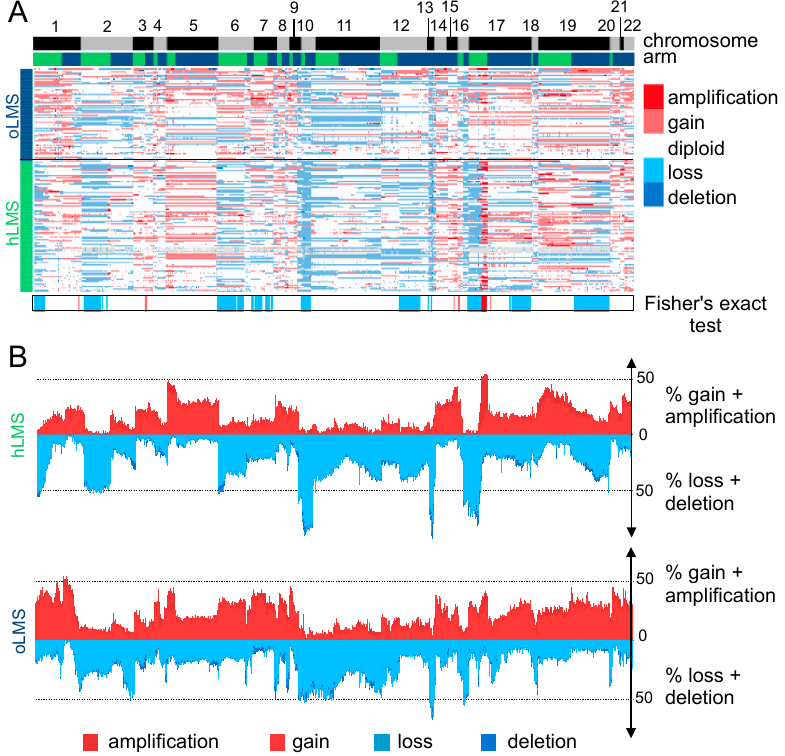
Figure 4. Copy number analysis of 7479 genes in LMS merged cohort (84 Affymetrix (CGH), 39 ICGC (WGS), and 62 TCGA (CGH) patients). ( A ). Heatmap showing copy number of genes (columns) in each patient (rows). Patients are grouped according to LMS type (hLMS: green, oLMS: blue). Annotations above the heatmap show chromosomes from 1 to 22 alternating grey and black and arms (p: green, q: blue). The annotation below shows significantly enriched events in hLMS, Fisher’s Exact test p -value < 0.01. The color scheme is the same for copy number and enrichment: homozygous deletion: dark blue, heterozygous deletion: light blue, normal: white, light red: gain of one copy, dark red: gain of 4 or more copies. ( B ). Penetrance plot. The percentage ( y -axis) of gain (red) and loss (blue) events are represented in hLMS (top panel) and oLMS (bottom panel). Each position on the x -axis is a gene that corresponds to genes in A.